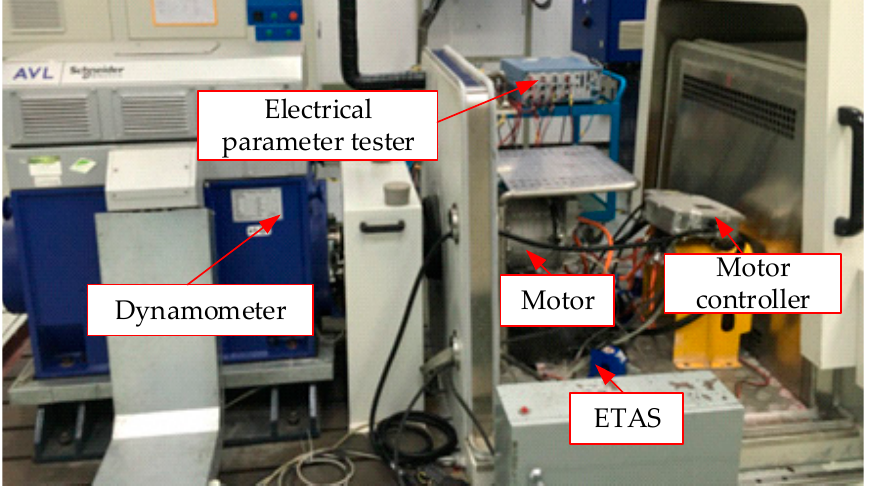
Figure 18. Experimental setup for temperature test.